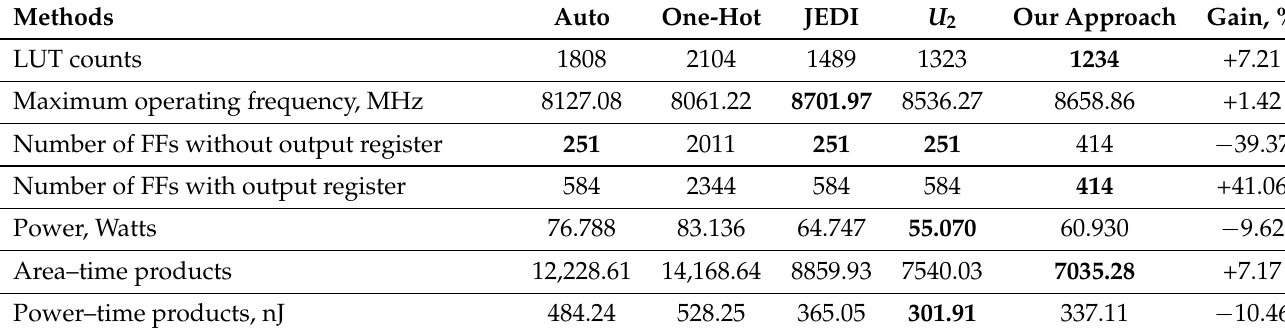
Table 21. Final comparative